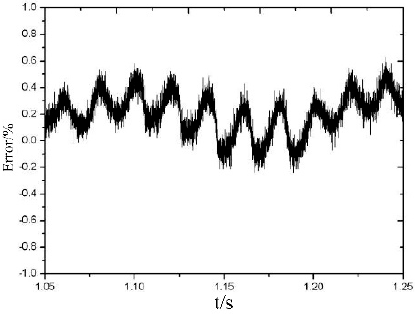
Figure 21. DC voltage error of voltage sag.